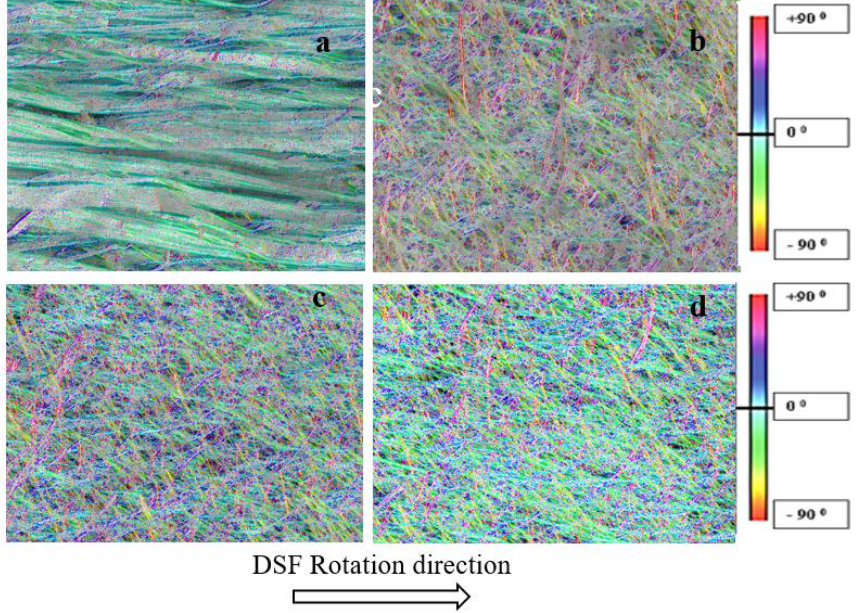
Figure 7. The colour-coded maps obtained with OrientationJ for: ( a ) fibre bundles ( b ) random mats and ( c , d ) fibre mats produced using R46 and C10 nozzles, respectively.